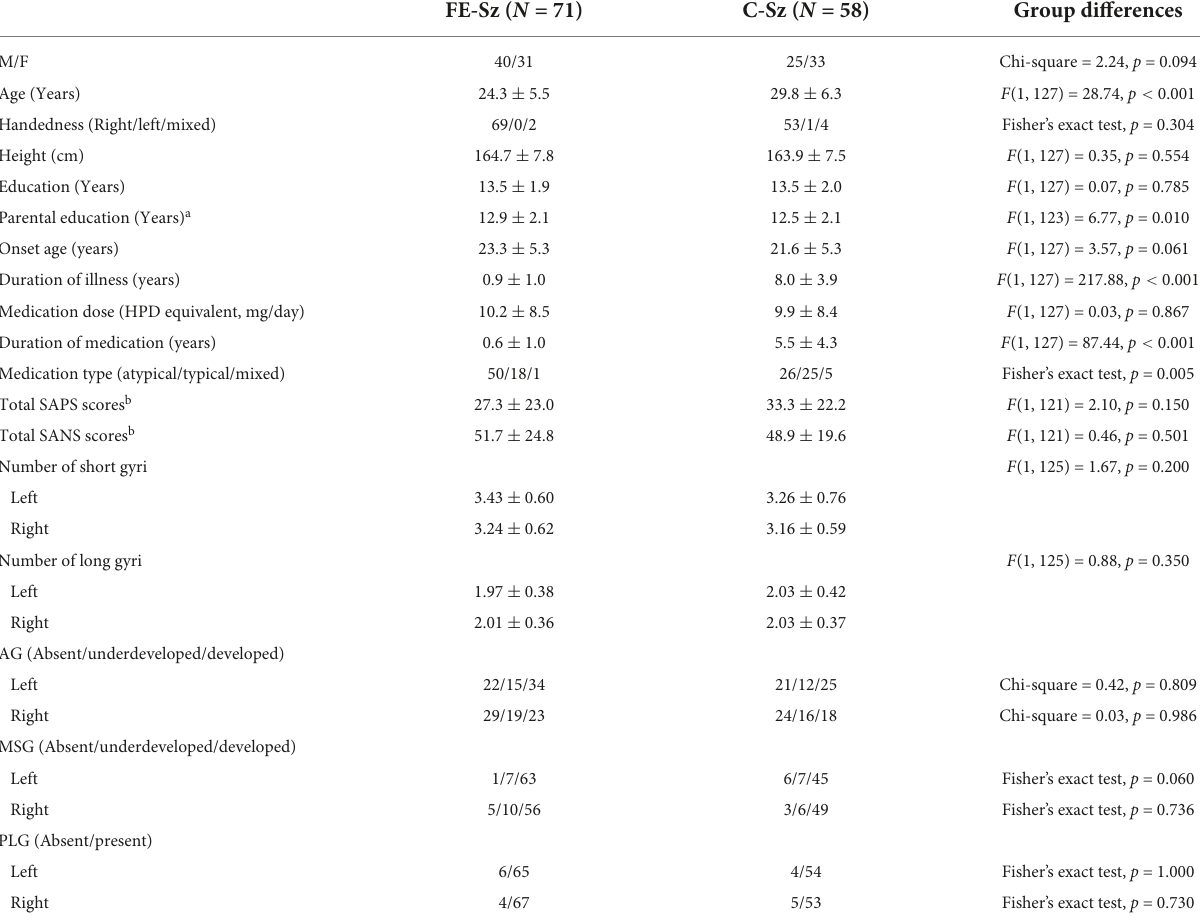
TABLE 2 Sample characteristics and gross insular morphology of first-episode (FE) and chronic (C)